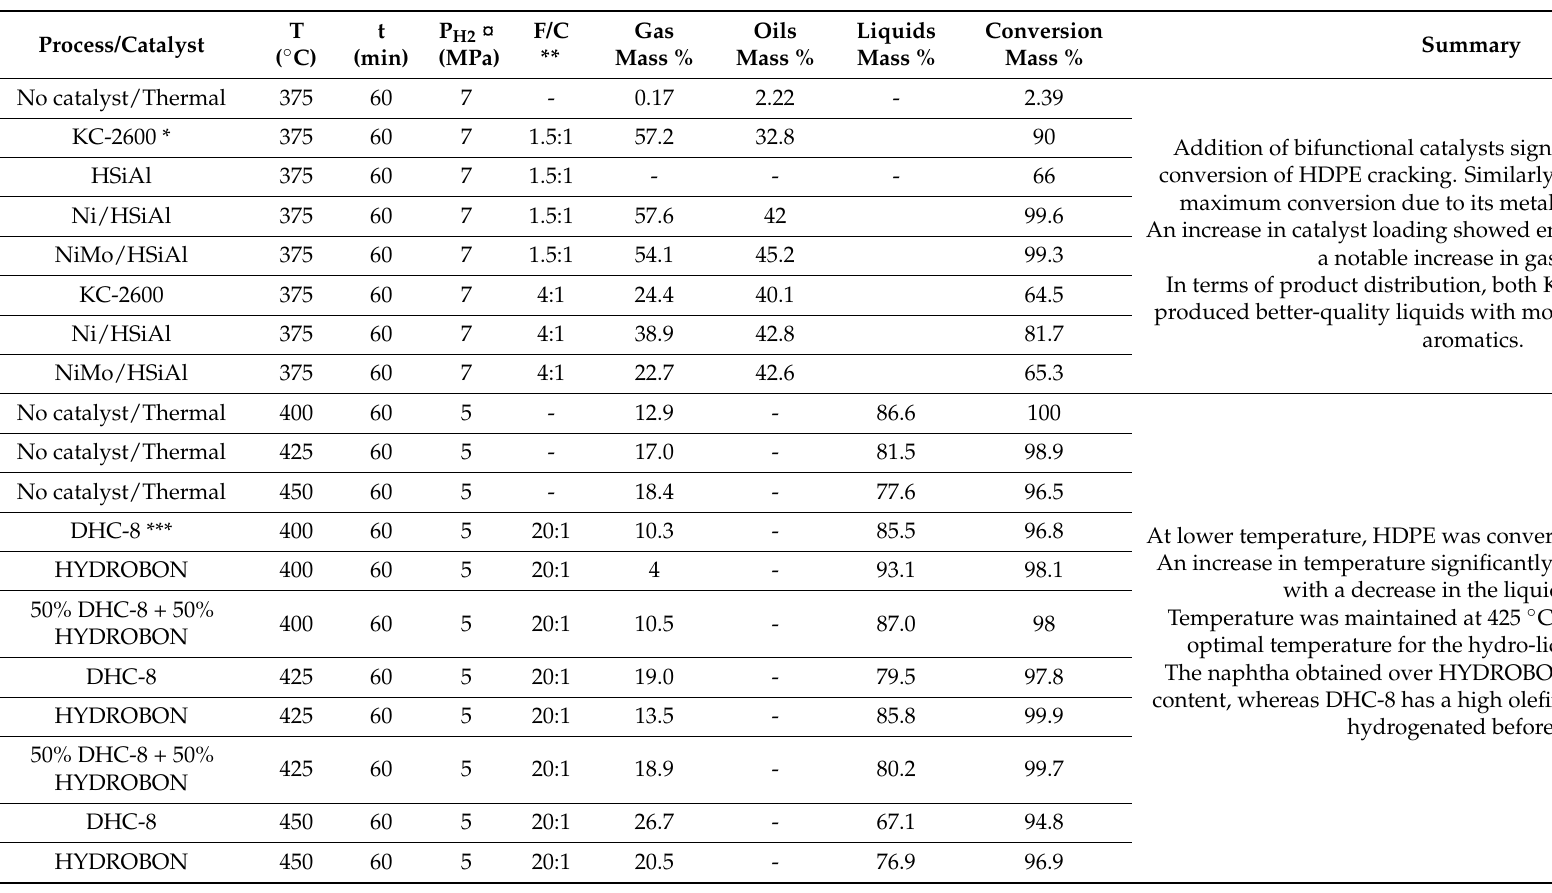
Table 9. Summary of HDPE hydrocracking